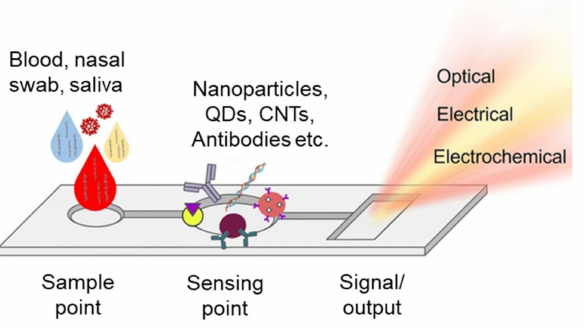
Figure 2. Basic representation of a microfluidic chip depicting the sample receiving point, the sensing point, and the signal/output